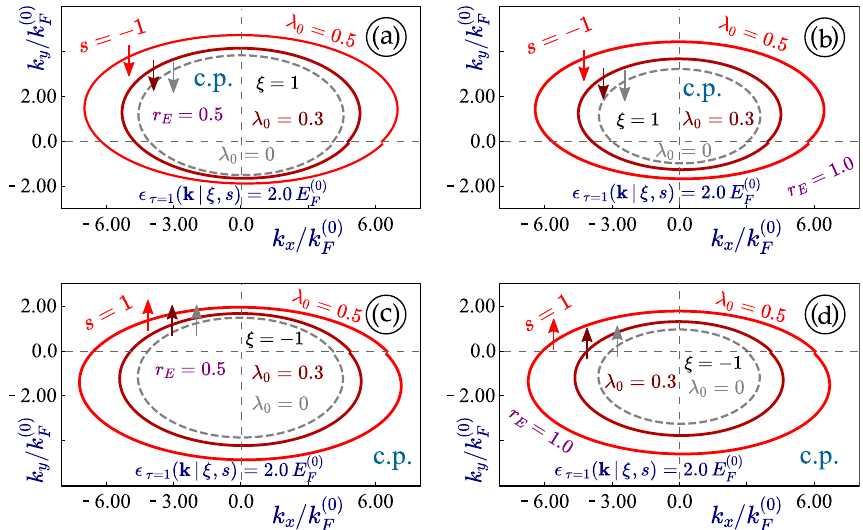
( L ) k ) 2.0 E ( 0 ) 0 ( F cut of the dispersions = 1 was = − 1 (and ξ 1 1 ) was chosen for panels ( a ), ( b ), while s = − = = + 0.5 [( a ), E =